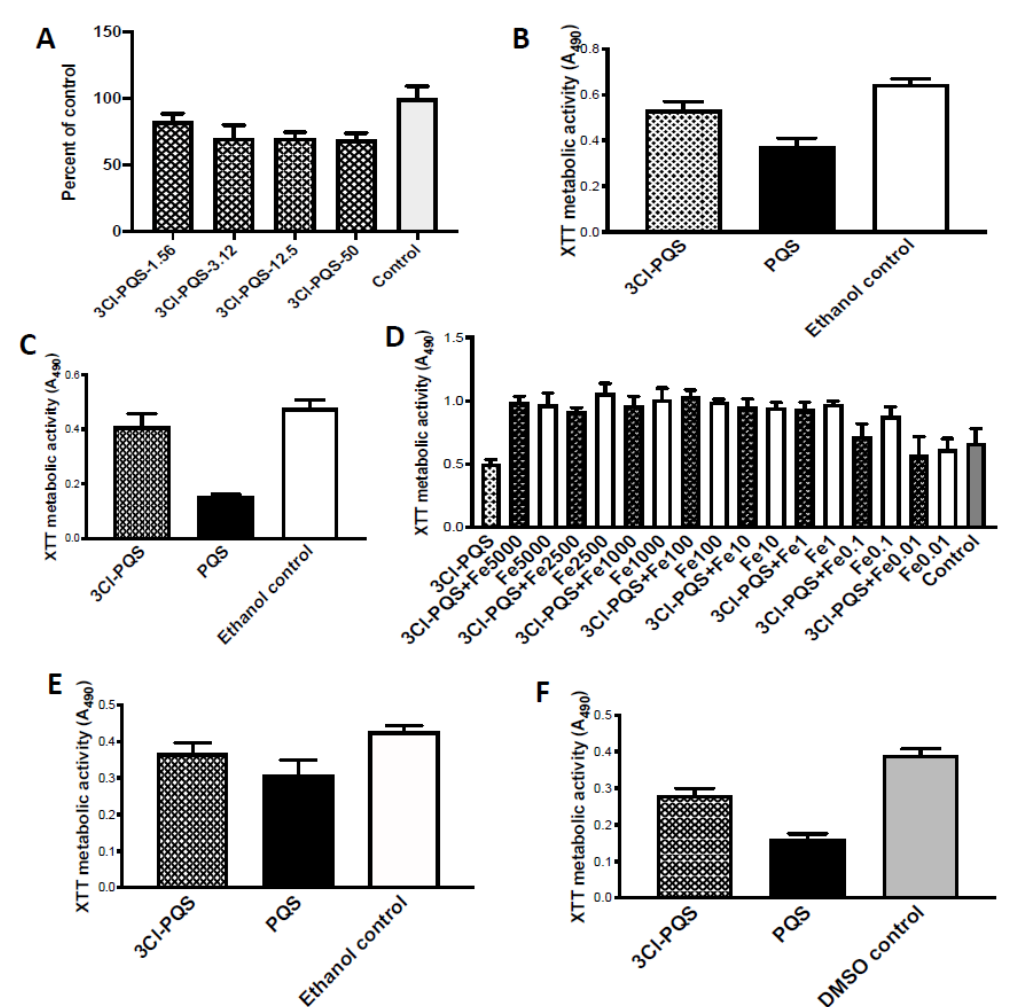
Figure 2. Studies with 3Cl-PQS on preformed Af biofilm metabolism, assessed by XTT assay. ( A ) Dose response study, strain 10AF, control (same amount of DMSO as in test articles). Designations 1.56, etc. are μg/mL. Dose-response is shal- low; 1.56 μg/mL, p < 0.01 compared to control, and other concentrations p < 0.001 compared to control. ( B , C ), comparison to PQS, all at 1.56 μg/mL, and to ethanol control (shown) identical to DMSO control. 3Cl-PQS is less inhibitory than PQS. In ( B ), using 10AF, 3Cl-PQS is p < 0.01, and PQS p < 0.001, compared to control; PQS is p < 0.001 compared to 3Cl-PQS. In